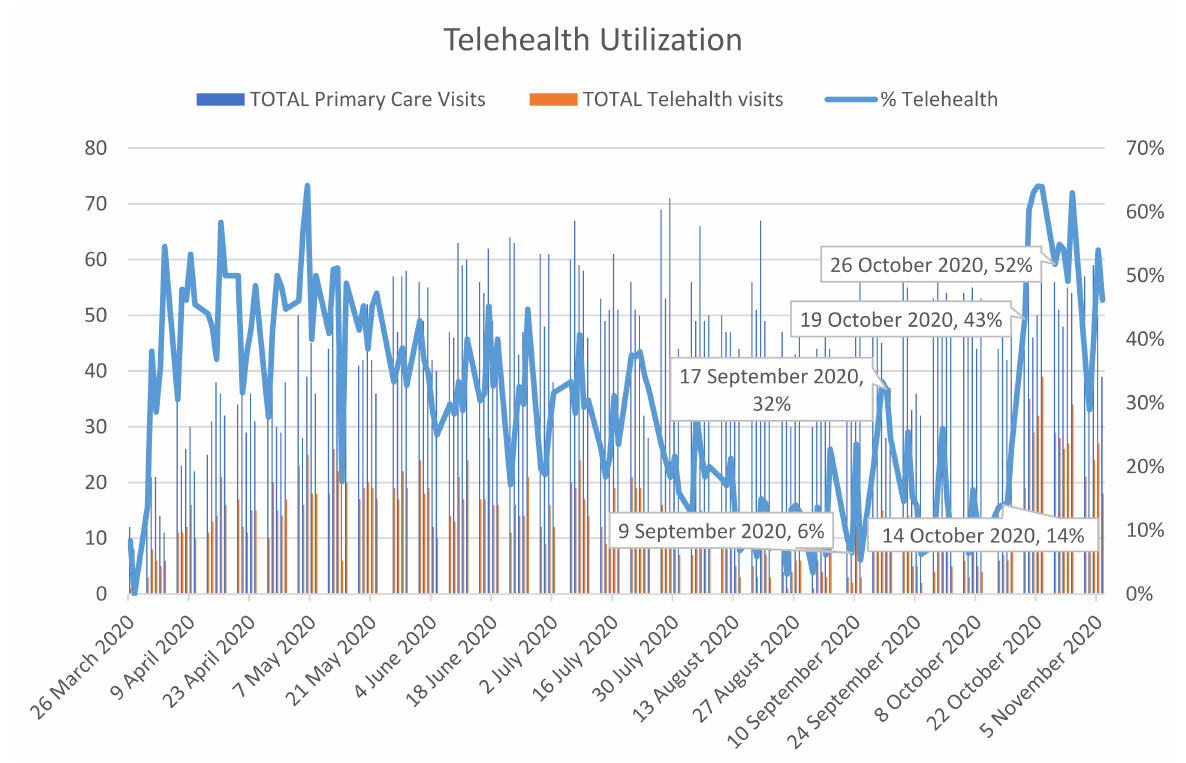
Figure 3. Telehealth